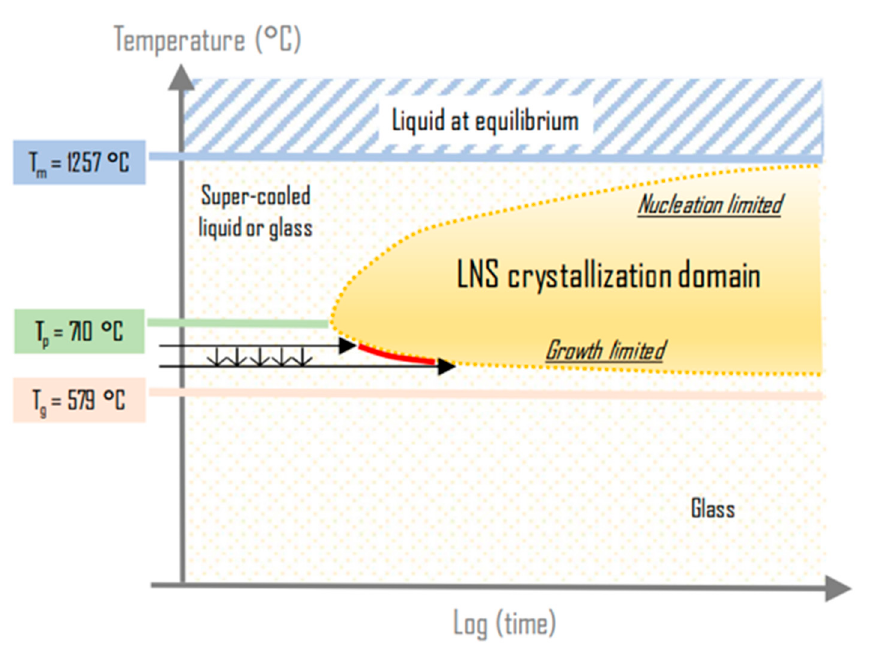
Figure 10. Sketch explaining the effect of scanning speed on the heat-affected volume (HAV) width. As the scanning speed decreases, the number of pulses deposited for a given volume increases. Consequently, the crystallization onset is reached at lower temperatures.